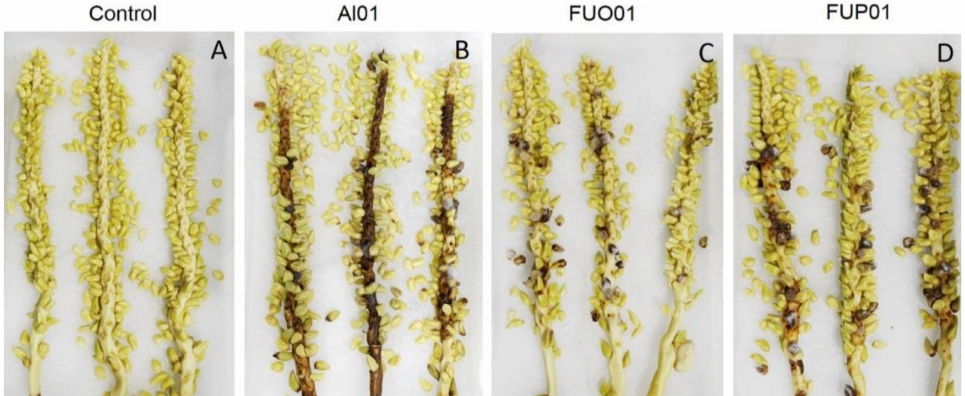
Figure 2. Pathogenicity test of Alternaria sp. and Fusarium sp. on coconut panicles: Control group ( A ), coconut panicles inoculated with Alternaria sp. Al01 ( B ), Fusarium sp. FUO01 ( C ), and Fusarium sp. FUP01 ( D ).